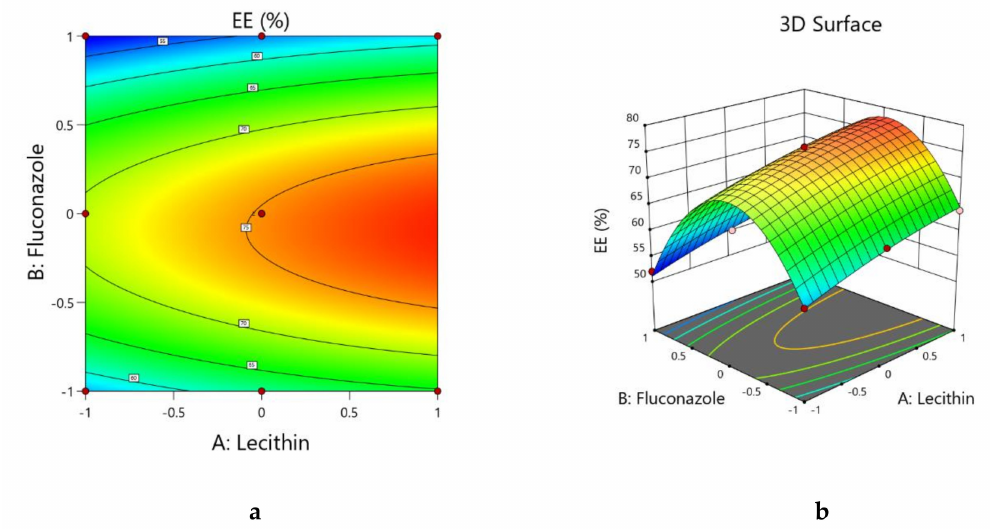
Figure 3. ( a ) Contour plot showing the interactions of lecithin and fluconazole with the EE% of the FS-NTF. ( b ) Three- dimensional surface plot showing the interactions of lecithin and fluconazole with the EE% of the FS-NTF.